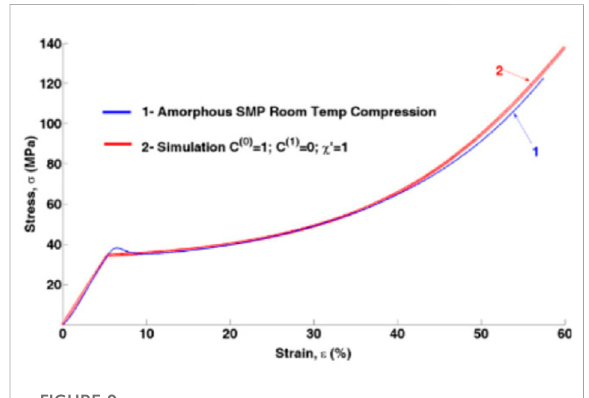
FIGURE 9 Compression test of an amorphous SMP matrix versus simulation data (Shojaei and Li, 2013). [Reproduced with permission from International Journal of Plasticity, 42: 31-49., (2013). Copyright 2013 Elsevier].